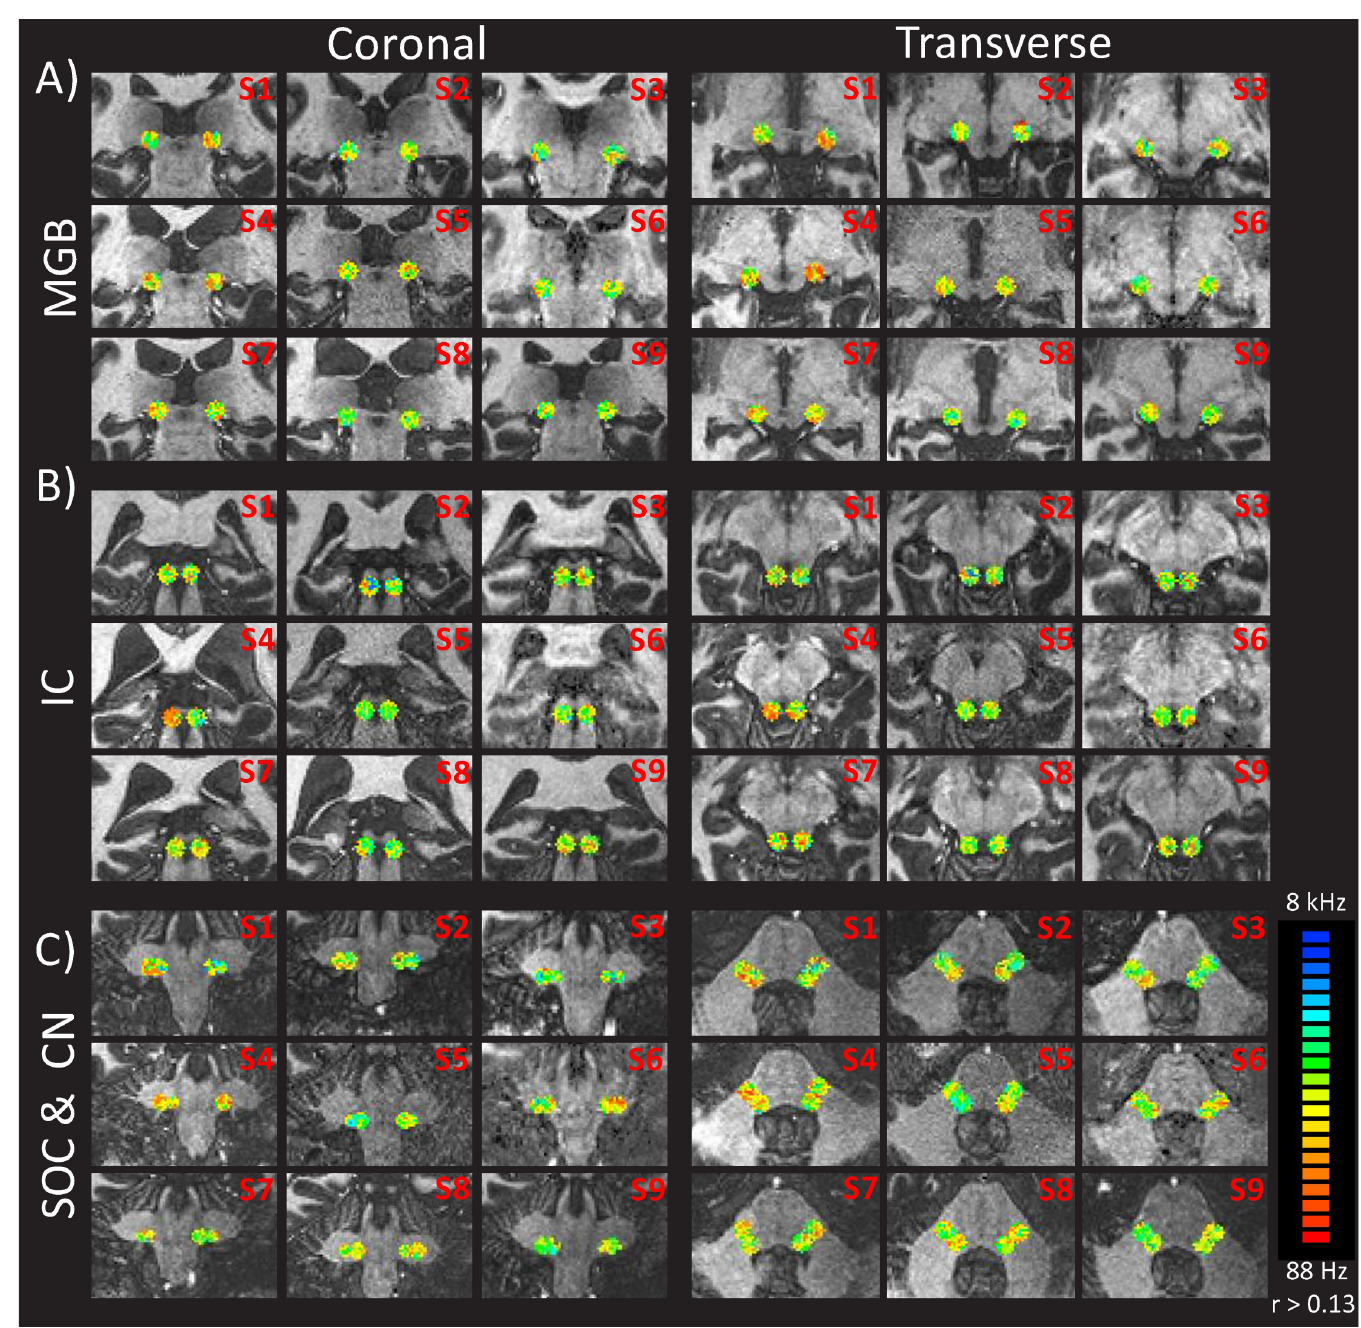
Fig 5. fMRI activations reflecting gradient of frequency preferences within the ROIs of A) the medial-geniculate bodies, B) the inferior-colliculus and C) the superior olivary complex and cochlear nuclei. The coronal and transverse maps are shown for all the subjects (subject number at top right corner). The threshold of the correlation values was set to r > 0.13 for visualization purposes only. Voxels preferring low frequencies are represented in red, while those preferring high frequencies are in